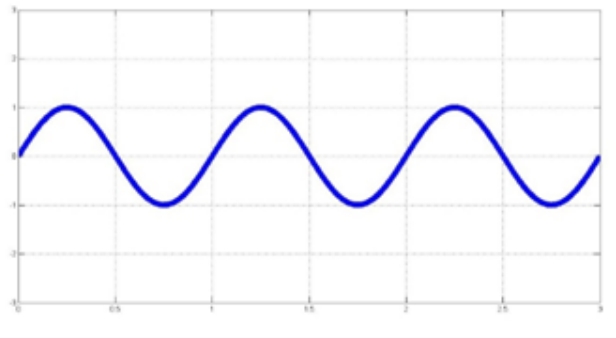
Figure 2. First sinusoid signal as y